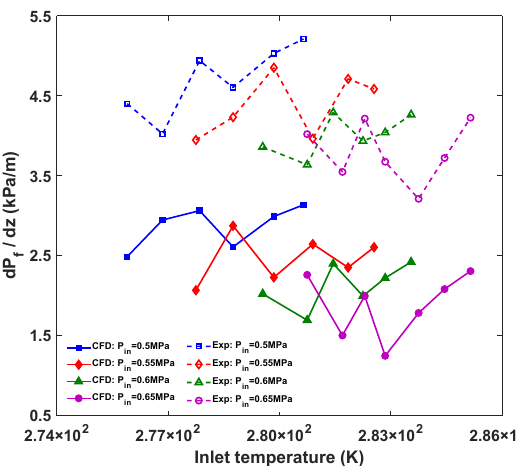
Figure 17. Comparison of the experimental dp for different pressures and G = 10.52 kg m - 2 s - 1 .